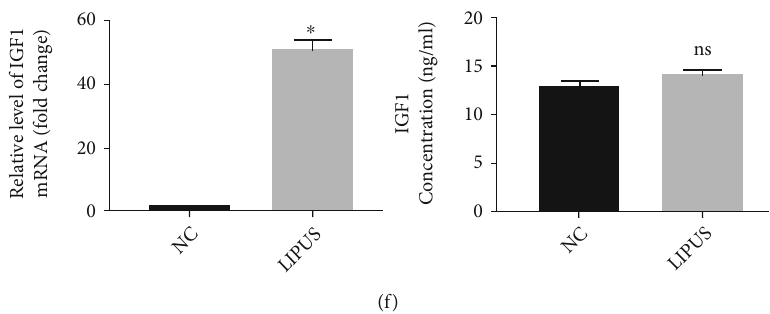
Figure 5: LIPUS promoted ADSCs to secrete cytokines. (-Fa – f) The CXCL12, FGF2, VEGF, NGF, HGF, and IGF1 mRNA expression levels and the concentrations of CXCL12, FGF2, VEGF, NGF, HGF, and IGF1 in the supernatant of the cell culture medium were measured using qRT – PCR and ELISA. Data are presented as the mean ± standard deviation. ns p > 0 : 05 when comparing the NC group. ∗ p < 0 : 05 when comparing the NC